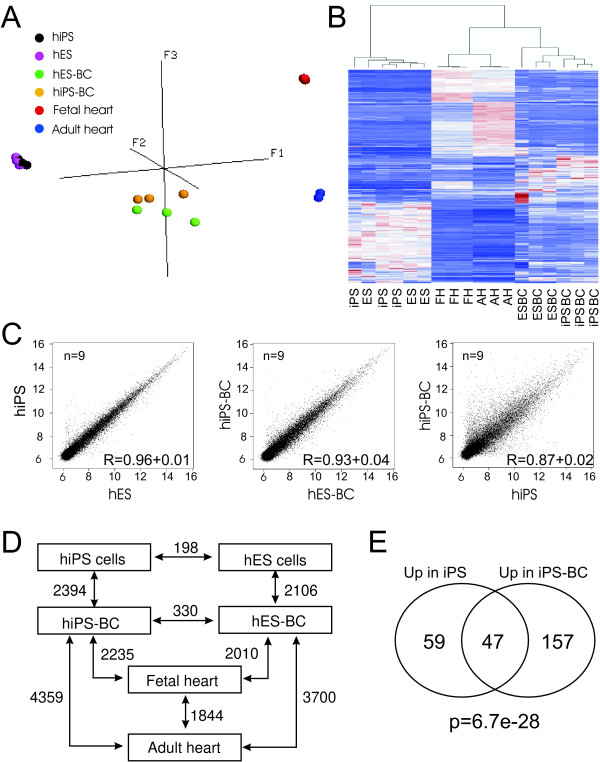
Global transcriptional analysis of human iPS and ES cells and their corresponding beating clusters. A. Principal component analysis of 4254 variant genes. B. Hierarchical clustering analysis of variant genes. C. Scatter-plots comparing global gene expression profiles between undifferentiated ES and iPS cells, iPS-BCs and ES-BCs and undifferentiated iPS cells and iPS-BCs. D. The number of differentially expressed genes (p < 0.05, 2- fold change) in various intergroup comparisons. E. Venn diagram of iPS cell-upregulated (compared to ES cells) and iPS-BC-upregulated (compared to ES-BCs) transcripts and the number of overlapping genes. The p-value has been calculated using the Fisher's exact test.